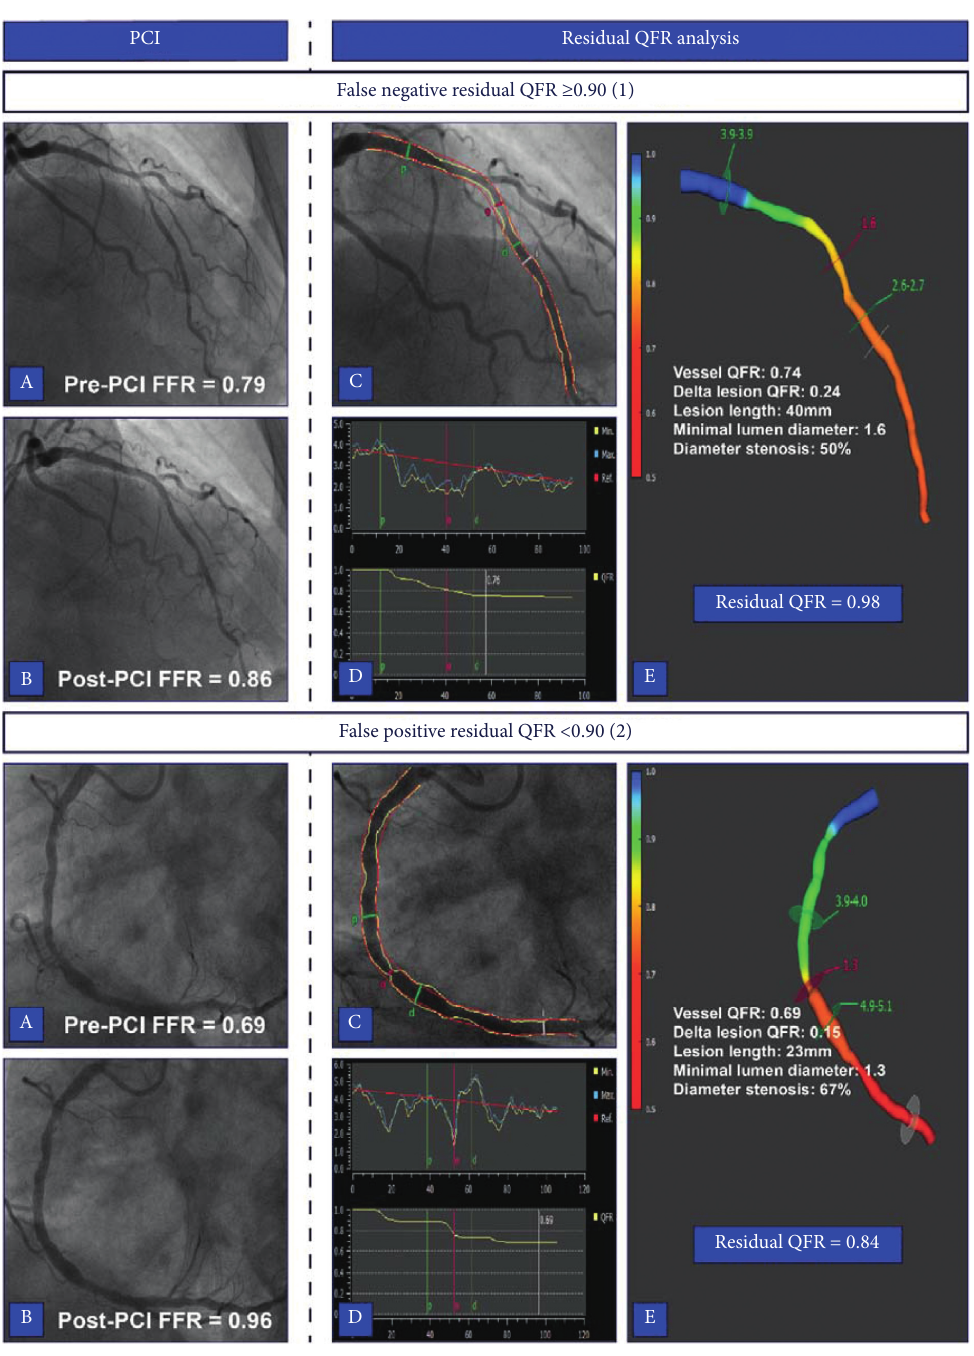
Figure 6: Case examples of false negative and false positive residual QFR results. Case 1 displays a false negative residual QFR result. Post- PCI FFR remained suboptimal after a successful intervention in proximal to mid LAD (1a-b). Residual QFR estimated a post-PCI FFR of 0.98, and there was no significant pressure drop observed beside that of the treated lesion (1c–e). Contrary, case 2 shows a satisfactory PCI result of the RCA (2a-b). However, residual QFR predicted a suboptimal PCI result based on the presence of additional stenosis that proved not to be functionally relevant (2c–e). FFR, fractional flow reserve; PCI, percutaneous coronary intervention; QFR, quantitative flow ratio; LAD, left anterior descending artery; RCA, right coronary